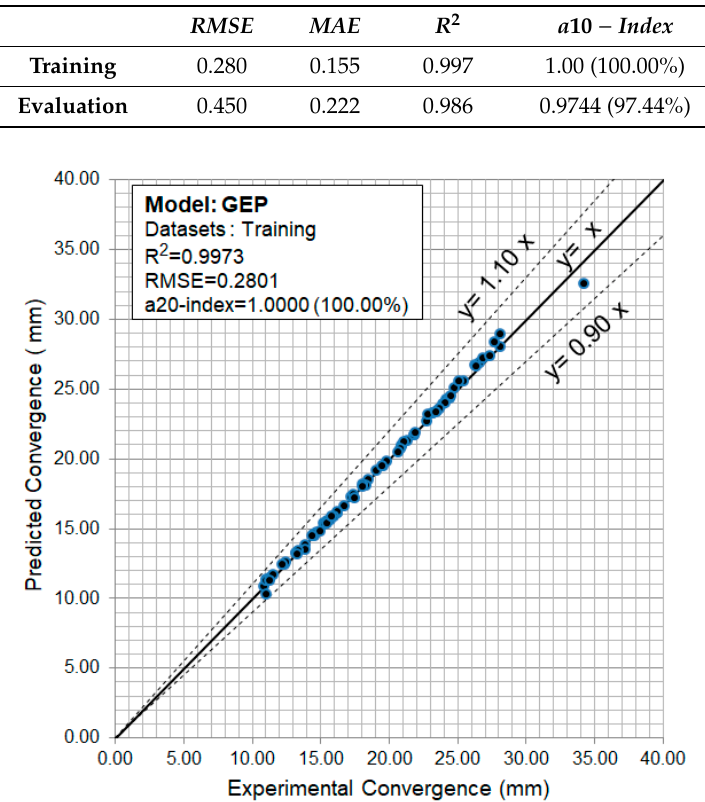
Figure 16. Scatter plot of measured and predicted convergence for training datasets.